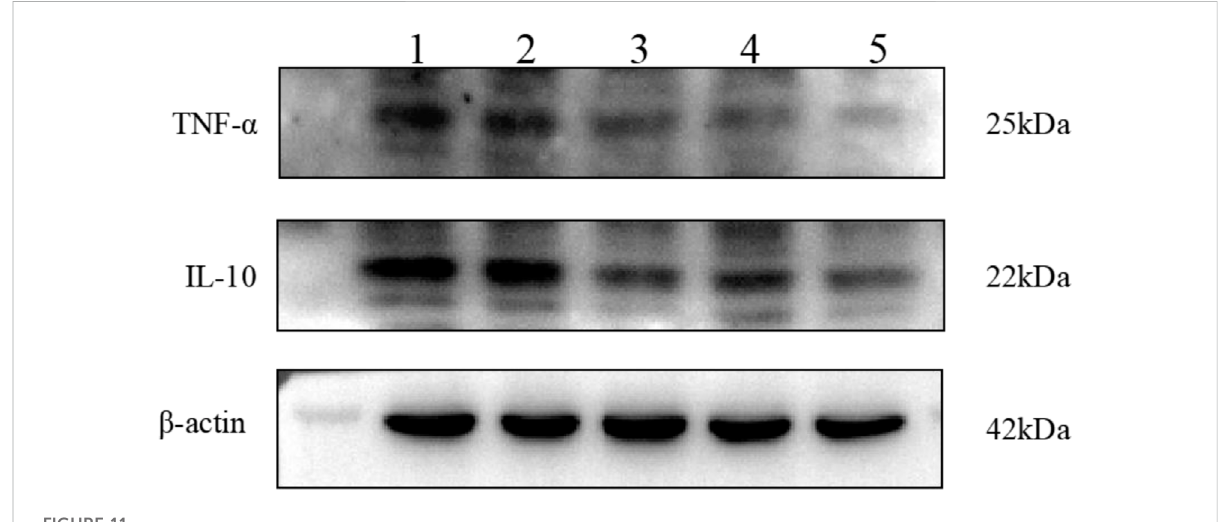
TheeffectofdifferenttreatmentonIL-10andTNF- α expressionofHepG2cell.1)ultrasound;2)FFA+ultrasound;3)NBs+FFA+ultrasound;4) NBs@Cu 5.4 O NPs@Res + FFA + ultrasound; 5)Apt-NBs@Cu 5.4 ONPs@Res + FFA + ultrasound.